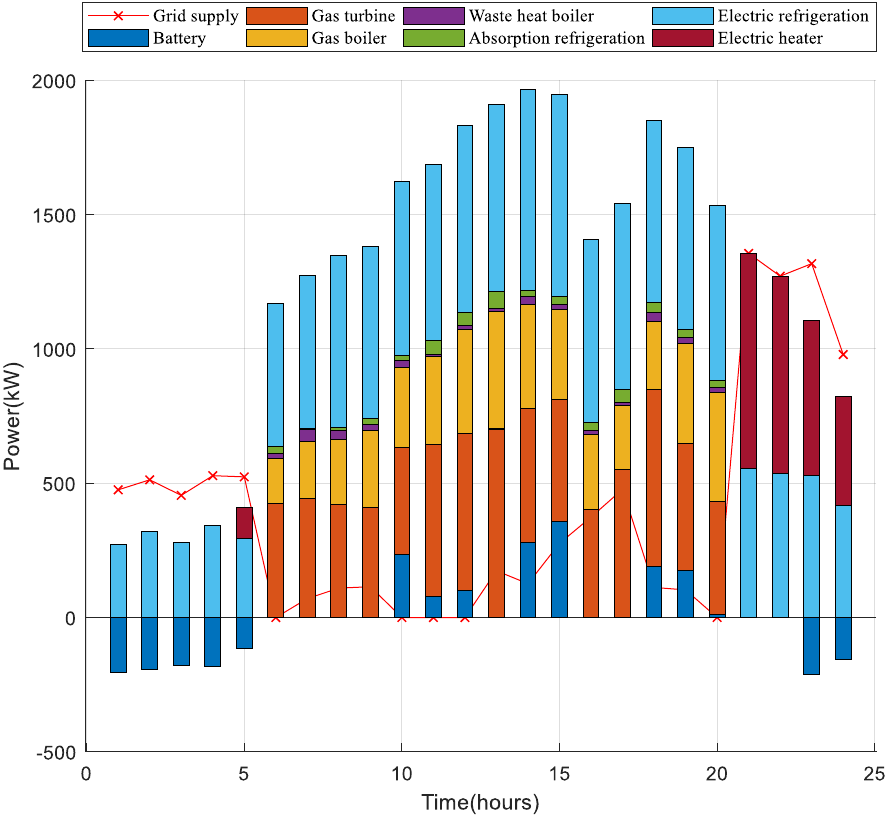
Figure 7. Typical daily optimal results in the summer season.